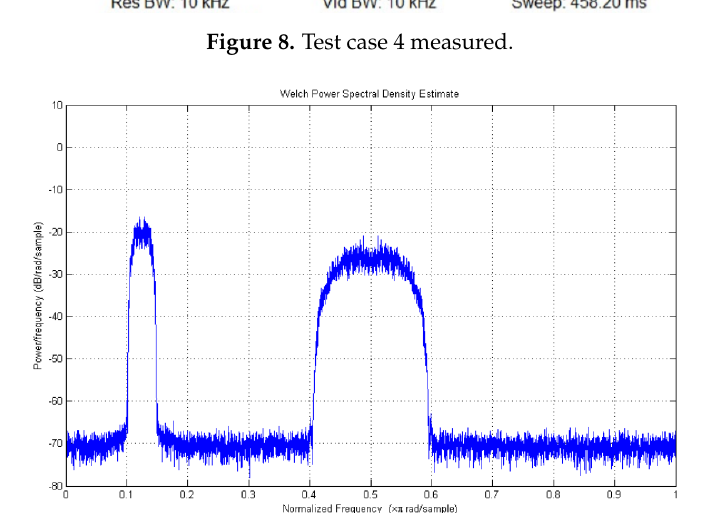
Figure 9. Test case 4